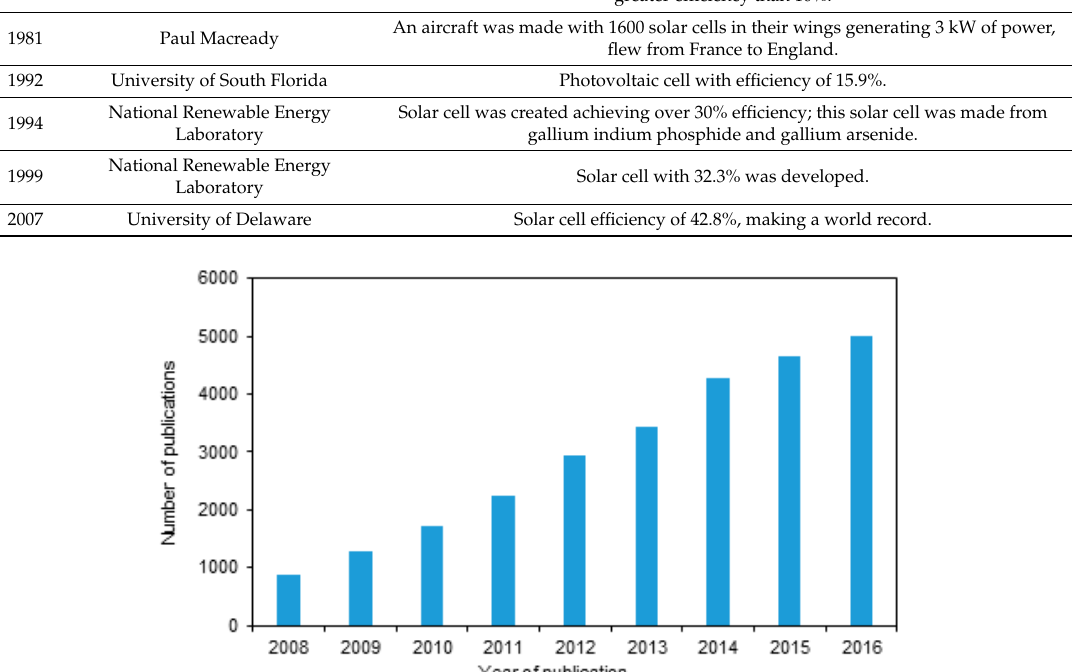
Figure 4. Number of academic publications in organic solar cells up to 2016 [ISI web of knowledge].